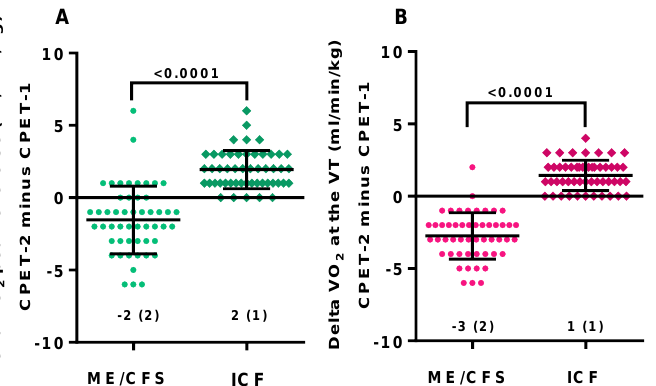
Figure 2. The range of absolute differences for peak VO 2 ( A ) and VO 2 at the ventilatory threshold ( B ) for female ME/CFS and female ICF patients. CPET: cardiopulmonary exercise test; ME/CFS: myalgic encephalomyelitis/chronic fatigue syndrome; ICF: idiopathic chronic fatigue; VO 2 : volume of oxygen consumption; VT: ventilatory threshold.